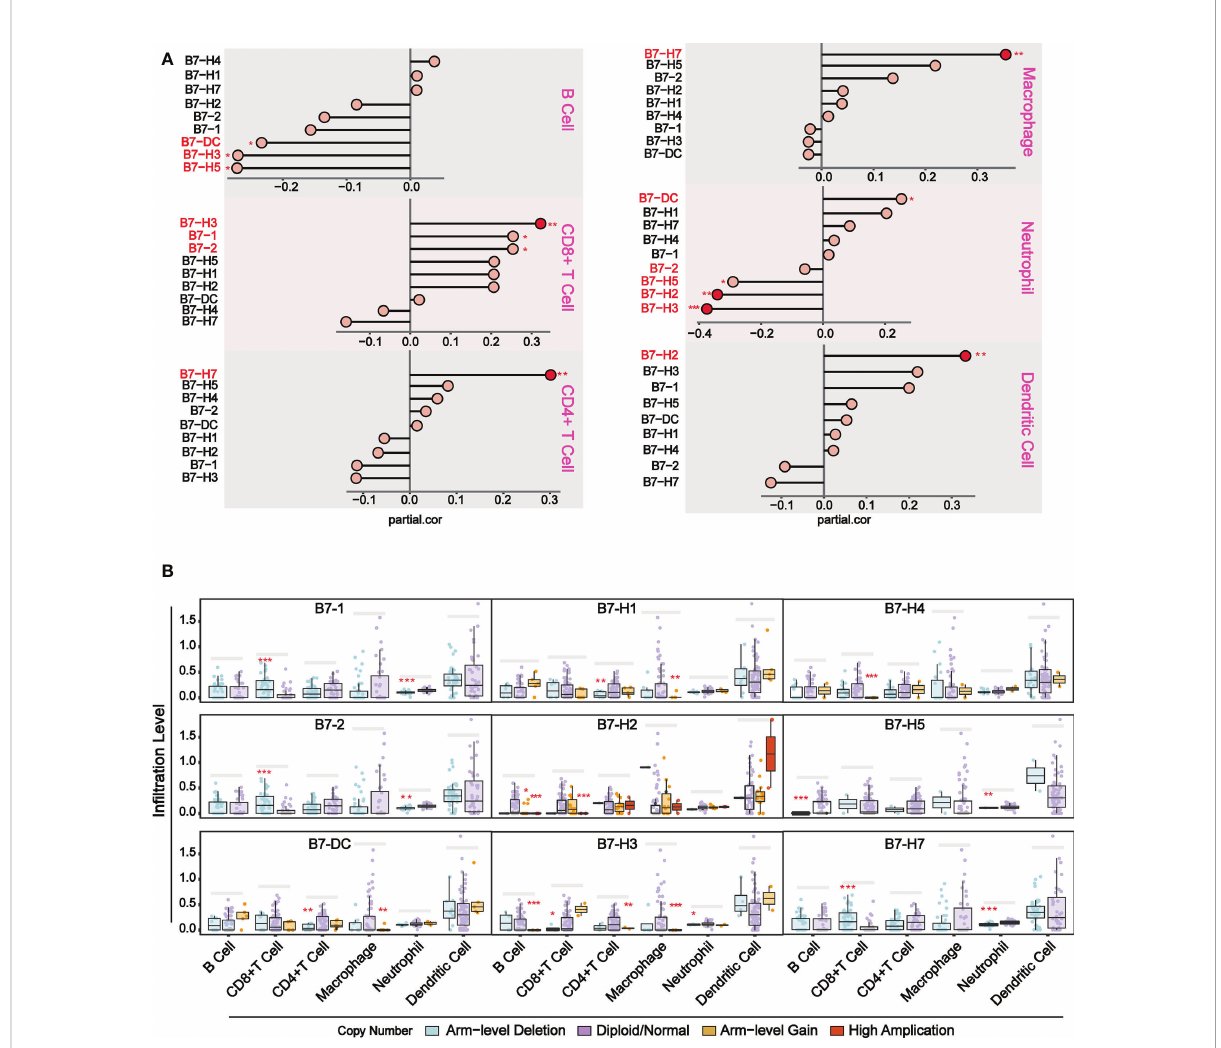
FIGURE 3 Association of immunologic in fi ltration with B7 family. (A) Correlation between B7 expression and in fi ltration level of immune in fi ltrating fl uid cells. (B) Association of immune cell in fi ltration level with B7 family somatic copy number alterations. The in fi ltration abundance in every somatic copy number alteration category was compared to the diploid/normal. (* P < 0.05**, P < 0.01, and *** P <